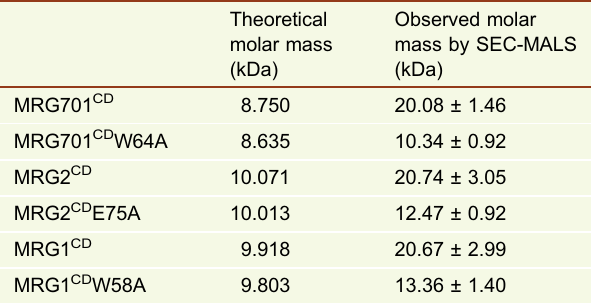
c Table 2. Molar mass (kDa) of wild-type proteins and mutants